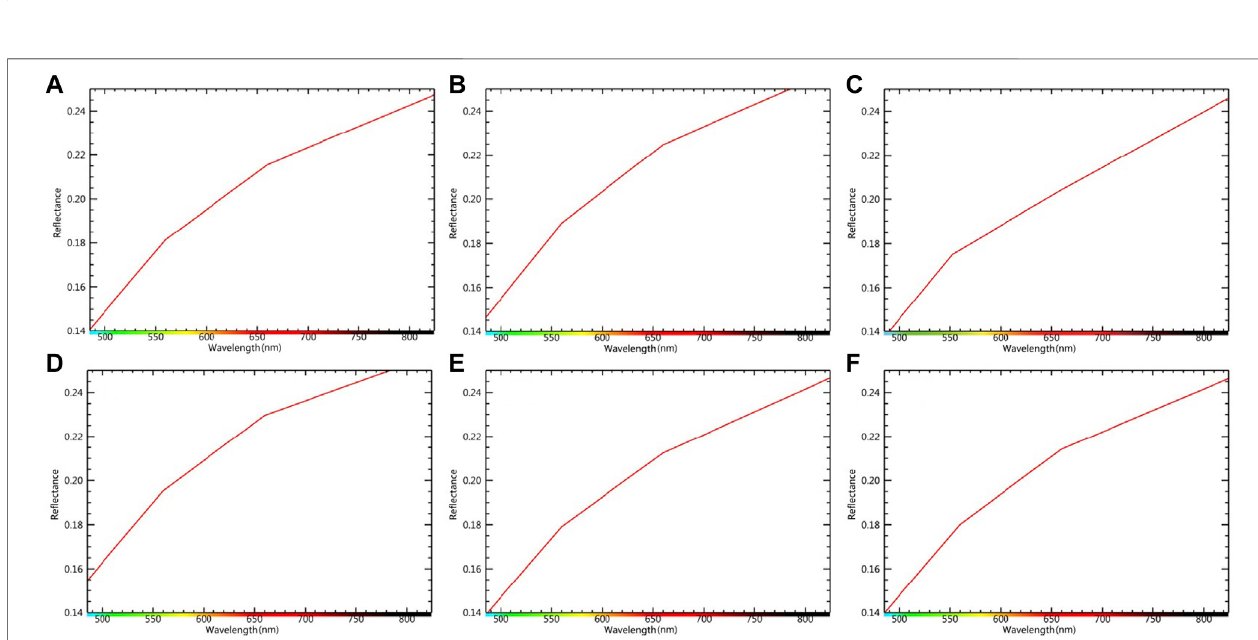
FIGURE 6 | The spectral re fl ectance curves of bare land with different image fusion methods (A) MS image (B) Pansharpening fused image (C) HPF fused image (D) GS fused image (E) PCA fused image (F) NND fused image.